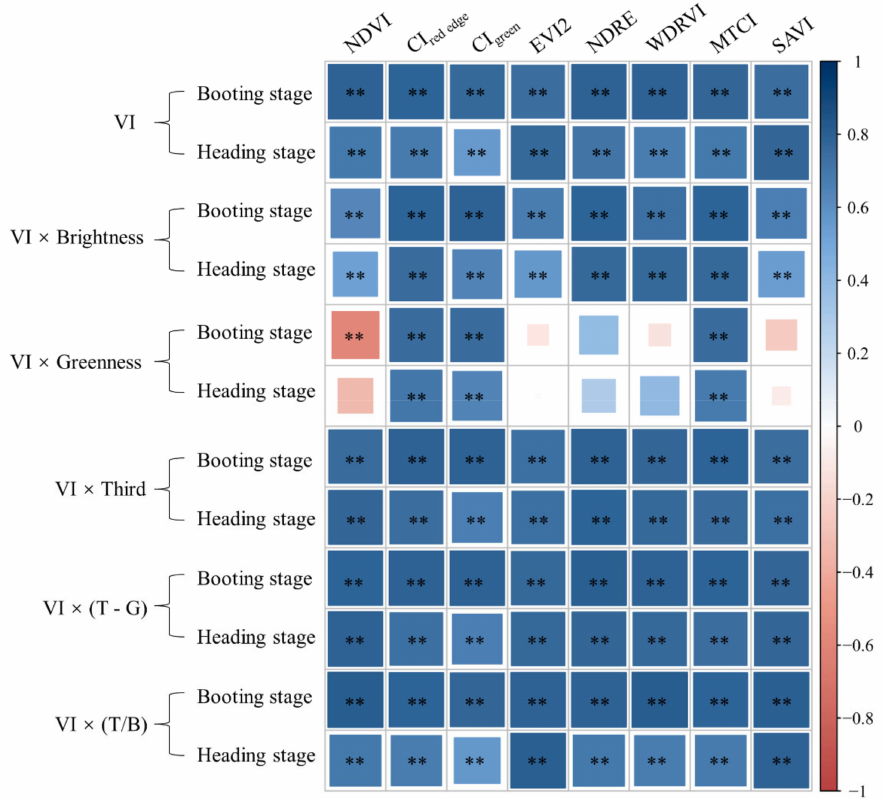
Figure 7. Correlation coefficients between parameters of VI and TCT combinations and yield (** indicates that the correlation is significant at the 0.01 level). Table 4. Yield-estimation models incorporating TCT parameters and VIs at the booting stage.